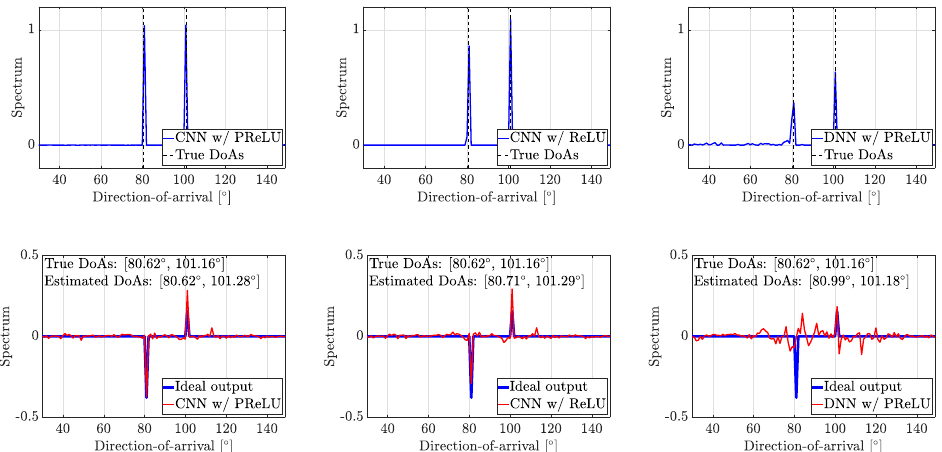
Figure 4. Outputs of the first-stage network and the second-stage network according to the type of NN and the activation function. The first row presents outputs of the first-stage network, and the second row presents outputs of the second-stage